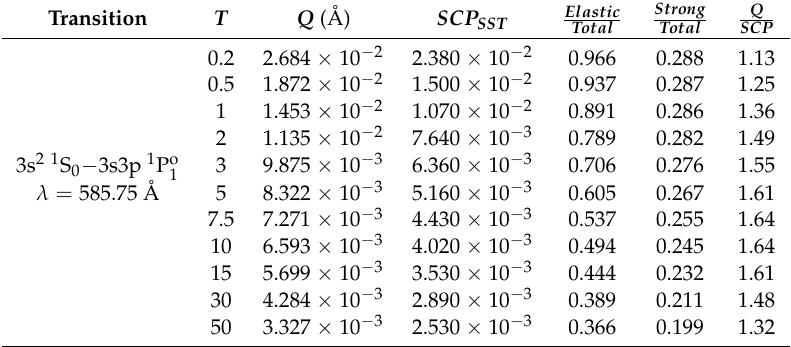
Table 5. Our Stark widths (FWHM) Q for the Ar VII 3s 2 1 S 0 − 3s3p 1 P o N e = 10 18 cm − 3 compared to the semiclassical results SCP SST obtained using the atomic data of the code SST. Elastic and Strong are respectively the contributions of elastic and strong collisions to SCP Total Total line broadening. T is expressed in 10 5 K.